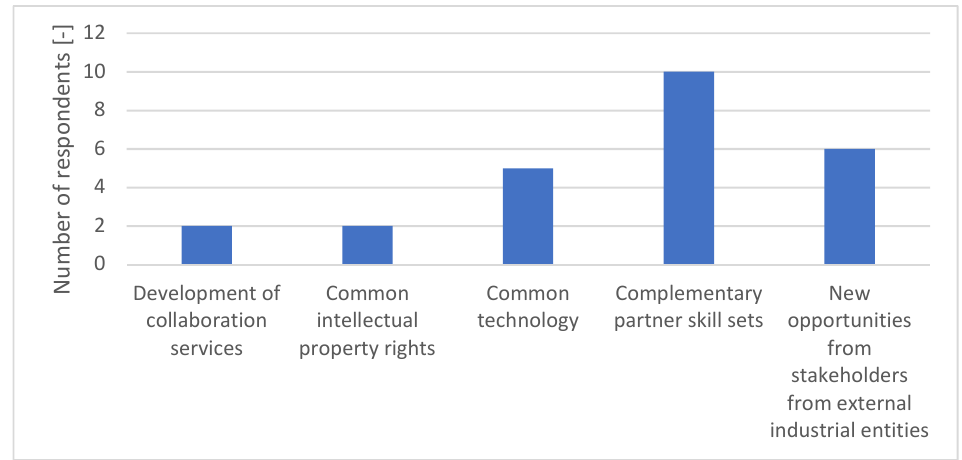
Figure 17. The reasons for the advantages of open systems of shared mobility over closed ones.